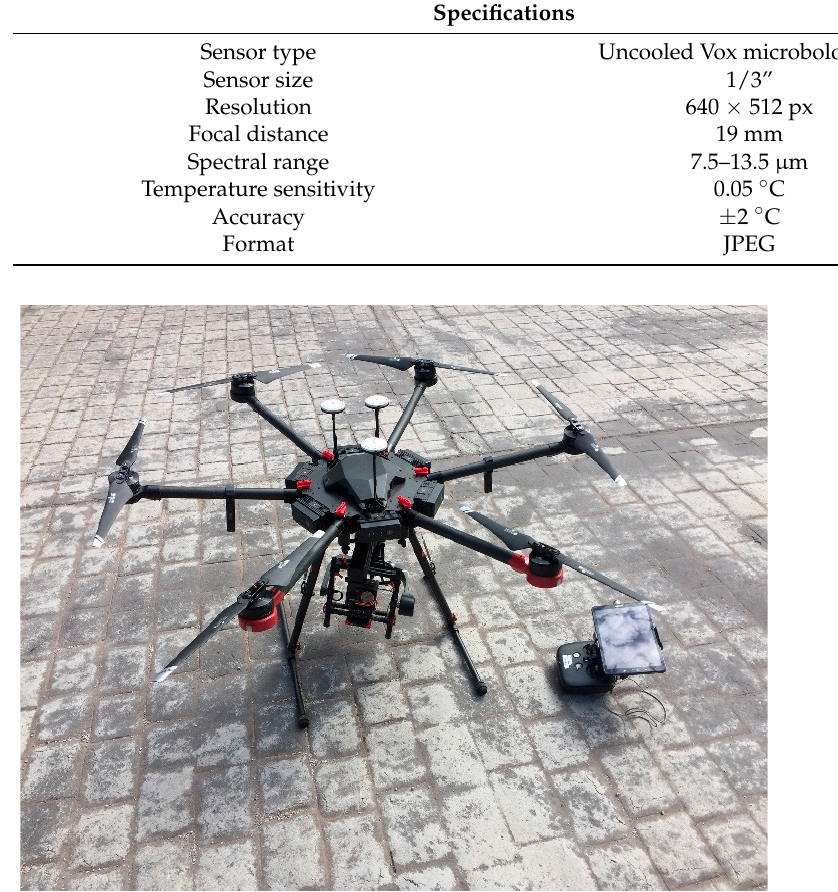
Figure 2. UAV DJI Matrice 600 and WIRIS Pro dual sensor used for image capture. Table 1. RGB dual sensor specifications.